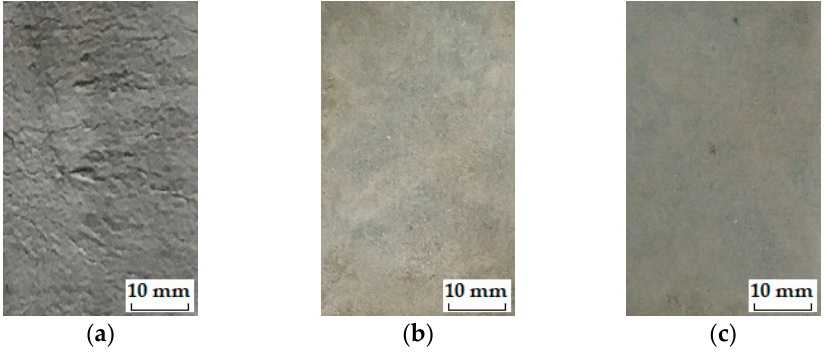
Figure 12. The surface appearance of typical ECC mixtures: ( a ) Mix. 6 after 25 cycles; ( b ) Mix. 4 after 175 cycles; ( c ) Mix. 9 after 200 cycles.